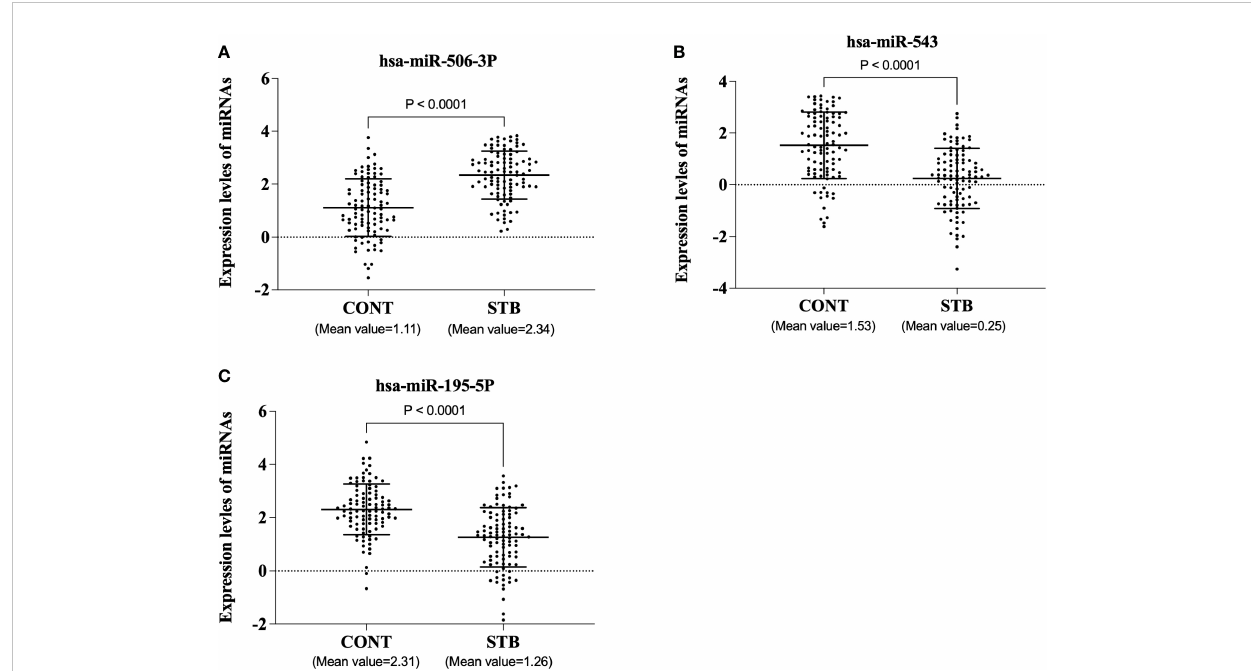
FIGURE 1 The expression levels of three miRNAs in the training cohort. The plasma samples were voluntarily collected, and miRNAs were isolated using a commercially available kit. qRT-PCR was performed according to the manufacturer ’ s protocol. The results were expressed as Log -delta Ct (delta Ct =